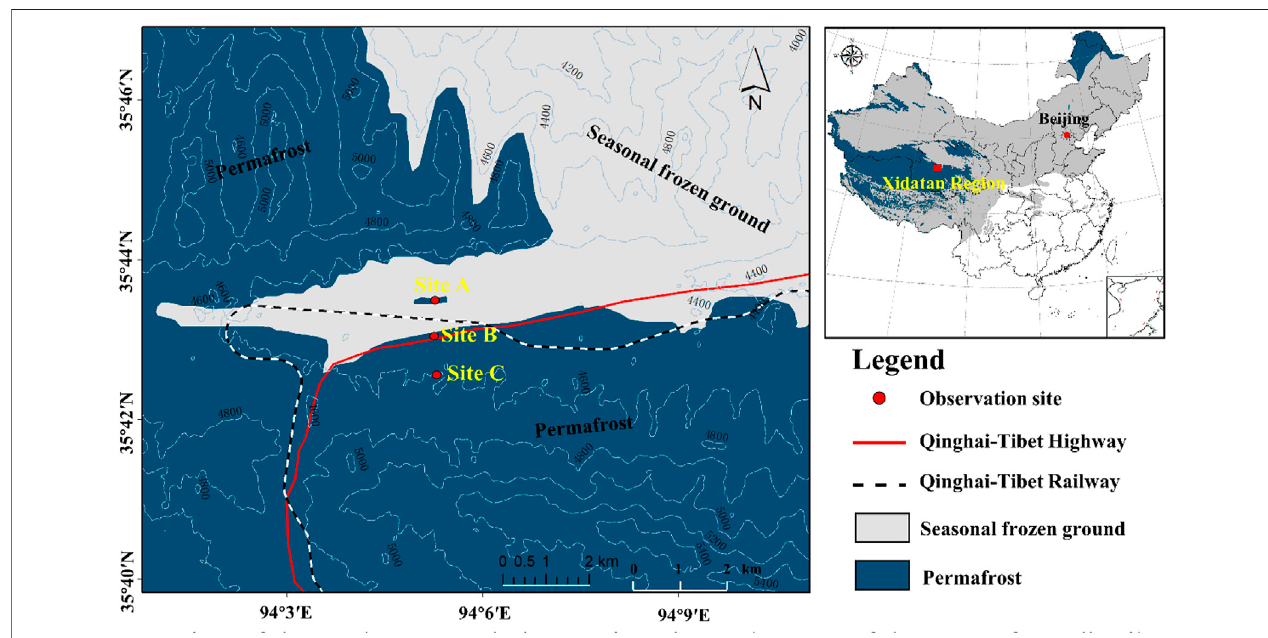
FIGURE1 | Location of the study area and observation sites. The map of the permafrost distribution in Xidatan was revised from Luo et al. (2018).